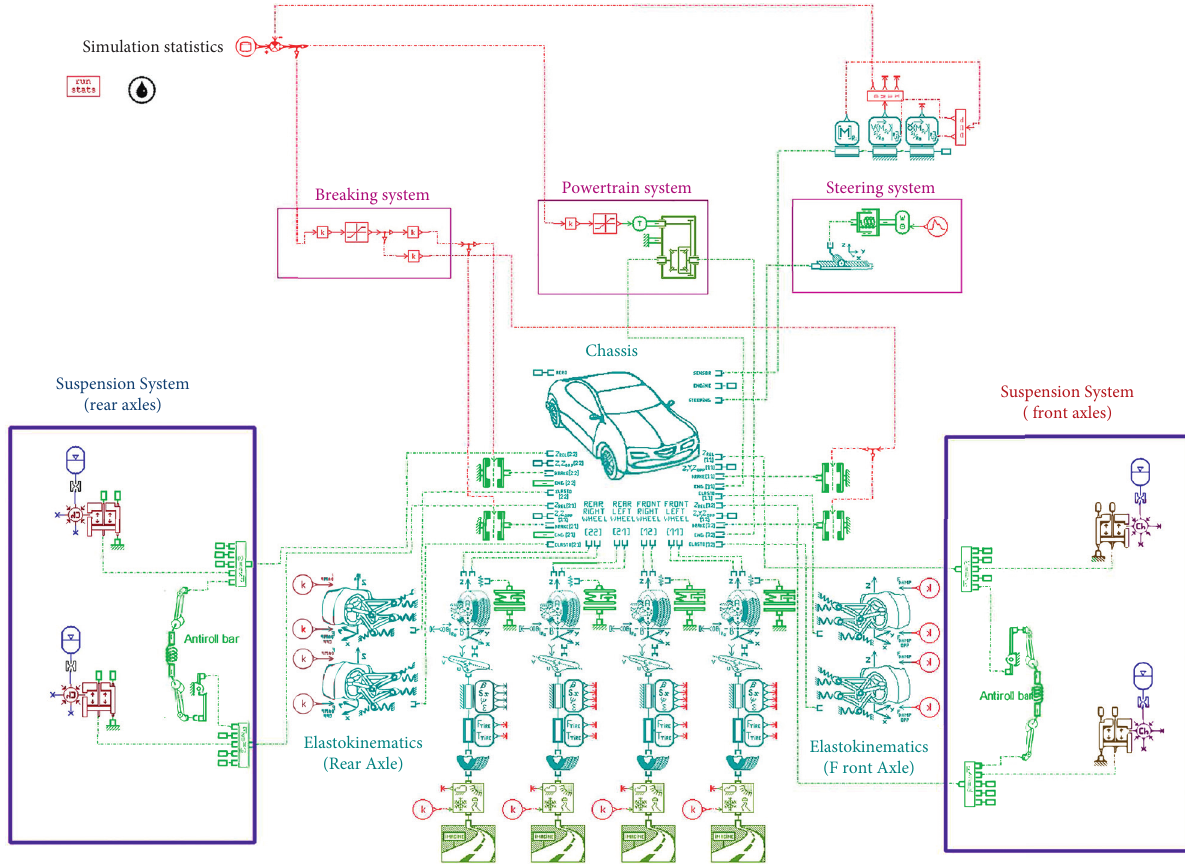
Figure 3: Vehicle dynamics model based on